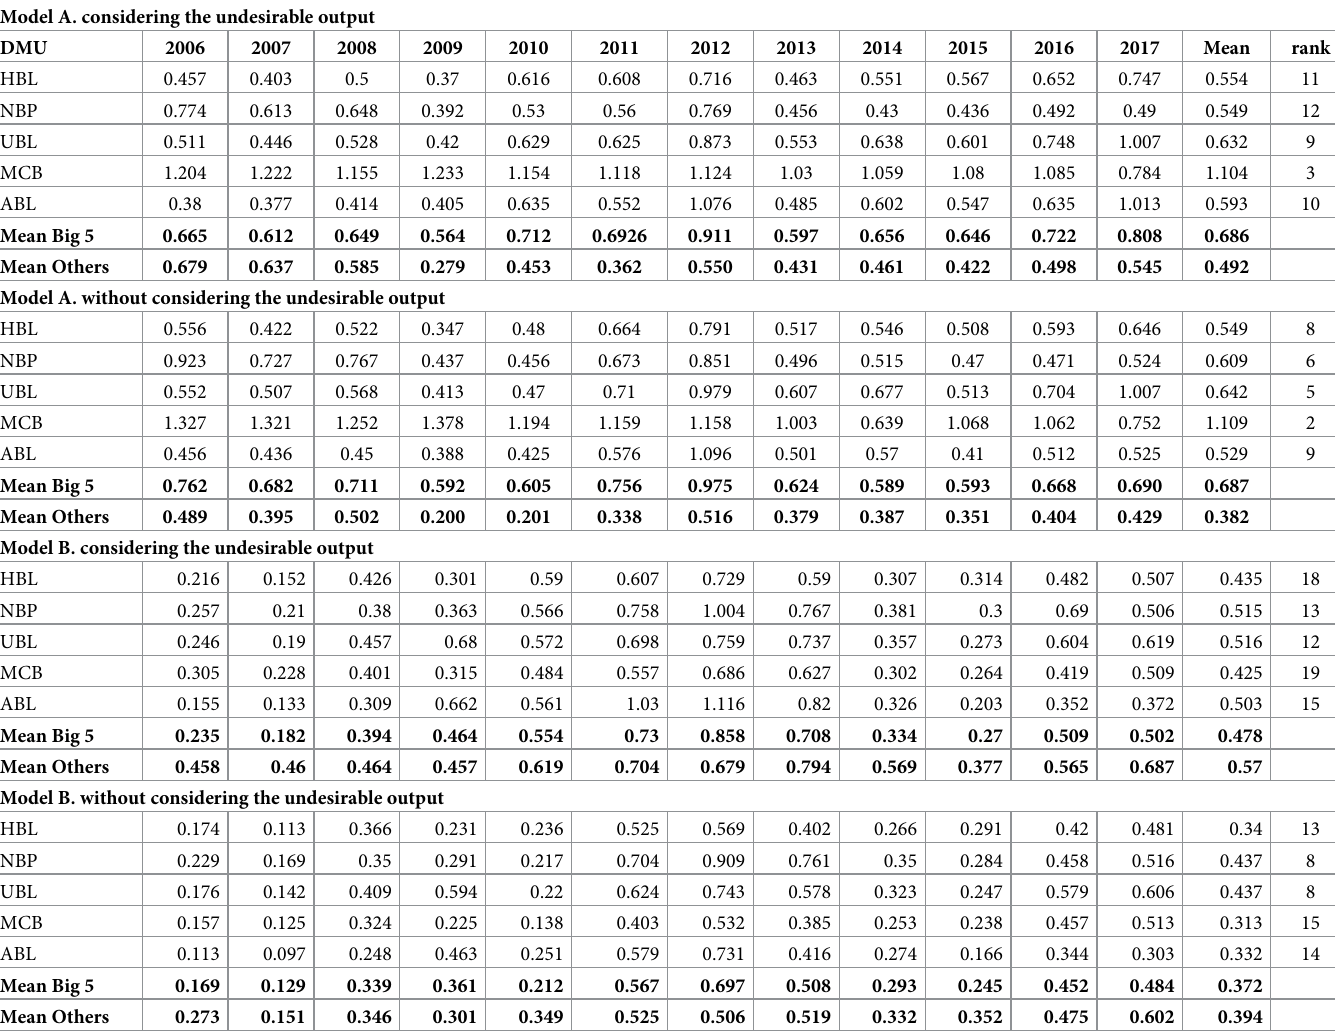
Table 6. Efficiency comparison between Big 5 CBs and other domestic CBs. Model A. considering the undesirable output